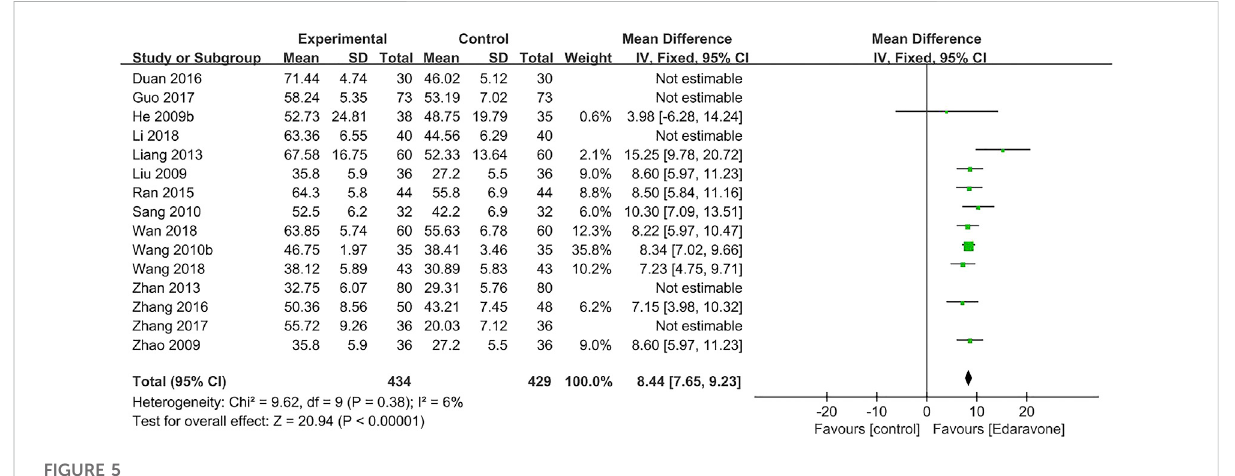
FIGURE 5 Forest plot for the effect of edaravone on BI.